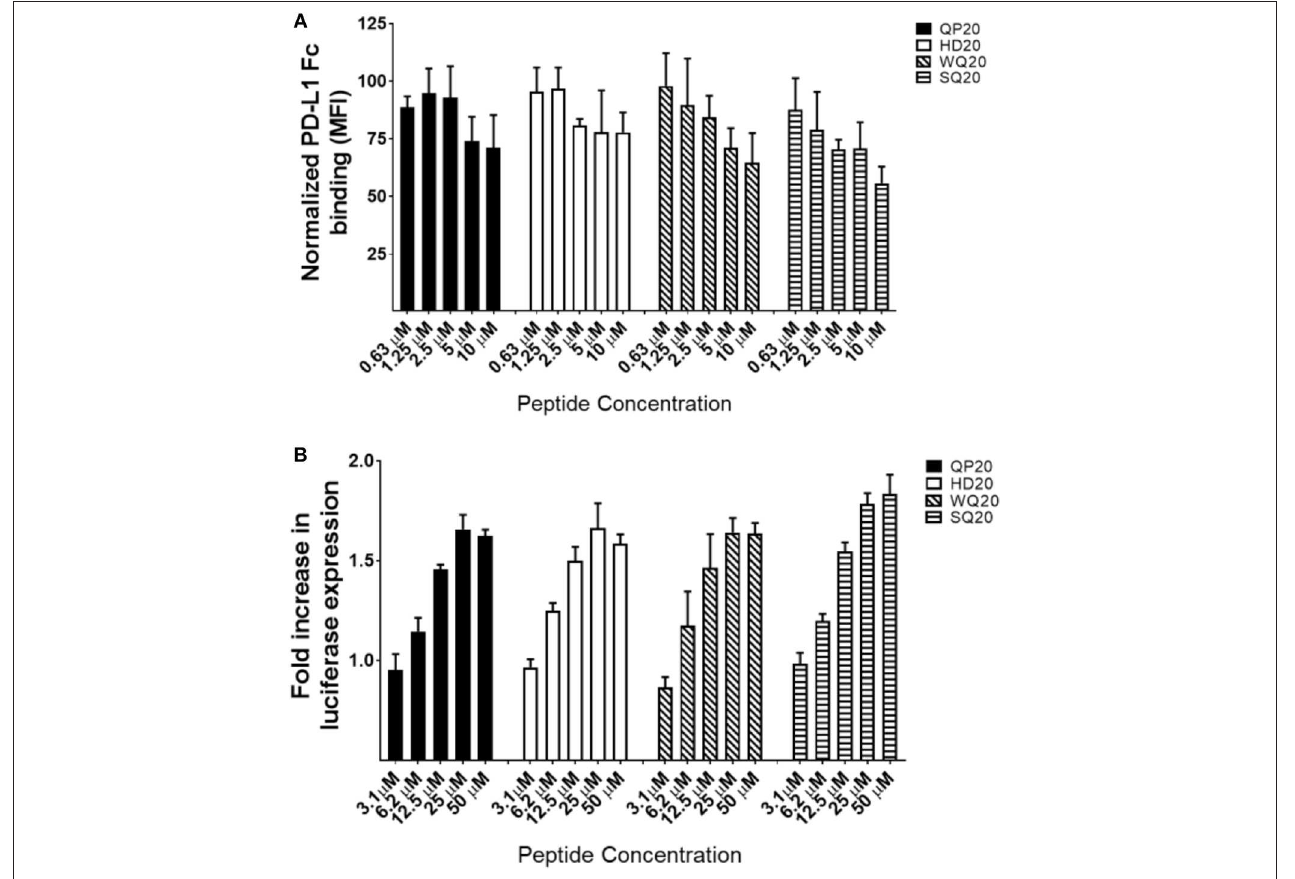
FIGURE 2 | Binding of peptides to PD1 on Jurkat T cells. (A) Jurkat T cells (effector cells) were pre-incubated with varying amounts of each peptide and then cells were washed and incubated with PD-L1-Fc protein. Bound PD-L1-Fc was detected with anti-human IgG conjugated to AF647, and cells were analyzed by flow cytometry. MFIs were normalized (per sample) against samples without peptide. Duplicate samples were tested. Error bars represent the standards of deviation. (B) Interference with the interaction between effector T cells (Jurkat) and target cells (CHO); target cells were cultured overnight and then incubated Jurkat cells with varying amounts of peptides in triplicate cells. After 6h, luminescence signals were measured. Fold increase in luminescence was calculated by dividing the RLU (relative luminescence units) of the treated cells by the RLU of the untreated